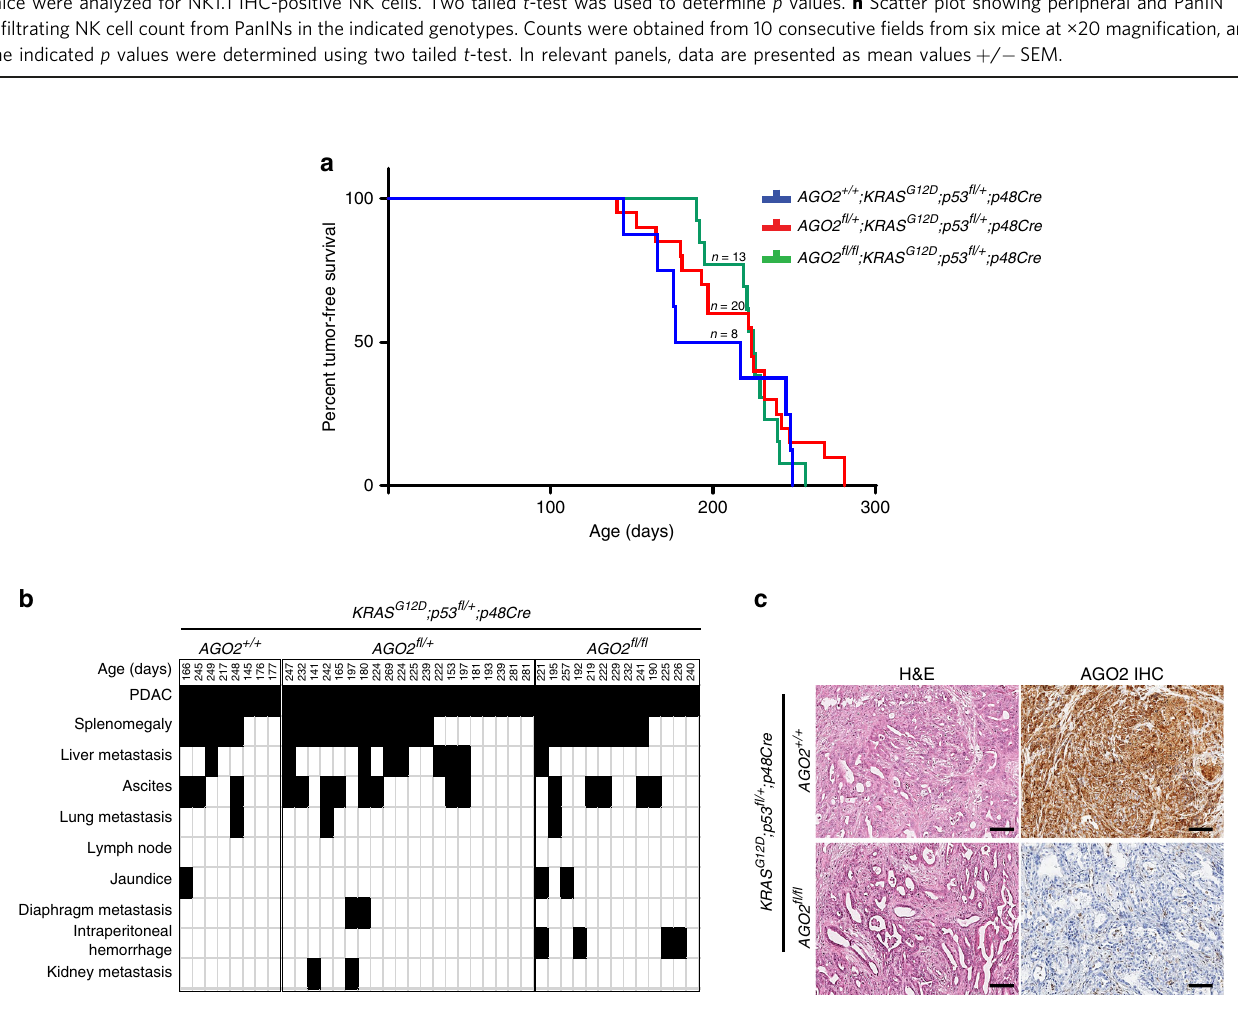
Fig. 2 AGO2 loss prevents PanIN to PDAC progression through OIS. a β -galactosidase staining of pancreatic sections from AGO2 + / + ; KRAS G12D ; p48Cre and AGO2 fl / fl ; KRAS G12D ; p48Cre mice at 70- and 500-day time points. Scale bar, 100 µ m. b Scatter plot showing β -galactosidase staining in low grade PanINs. Data are from 47 PanINs from AGO2 + / + ; KRAS G12D ; p48Cre and 98 PanINs from AGO2 fl / fl ; KRAS G12D ; p48Cre from four individual mice at the 70-day time point and 30 PanINs from three individual mice at 500-day time points. Intensity of staining and percent cells within 30 low grade PanINs were used to determine the senescence score = intensity × percent positive cells. p values were determined using a two sided t-test. Data are presented as mean values + / − SEM. c Immunoblot analysis of RAS-driven MAPK (indicated by pERK) and PI3K (indicated by pAKT) signaling from individual pancreata obtained from mice of the indicated genotypes, aged to 400 days. Numbers on the left indicate protein molecular weights in kDa. d Representative images of H&E staining (left) and dual staining for β -galactosidase and phospho-ERK (right) in human pancreatic tissue with PanINs (representative staining of at least 10 PanINs from two patients). Scale bar, 40 µ m. e Immune pro fi le of lesions from the indicated genotypes. Ten consecutive fi elds (20x magni fi cation) from four individual mice were assessed for the indicated IHC markers that distinguish immune cell populations. Signi fi cant p values are indicated and were determined using two tailed t -test. f Representative images of NK1.1-positive NK cells surrounding PanIN and PDAC lesions within the